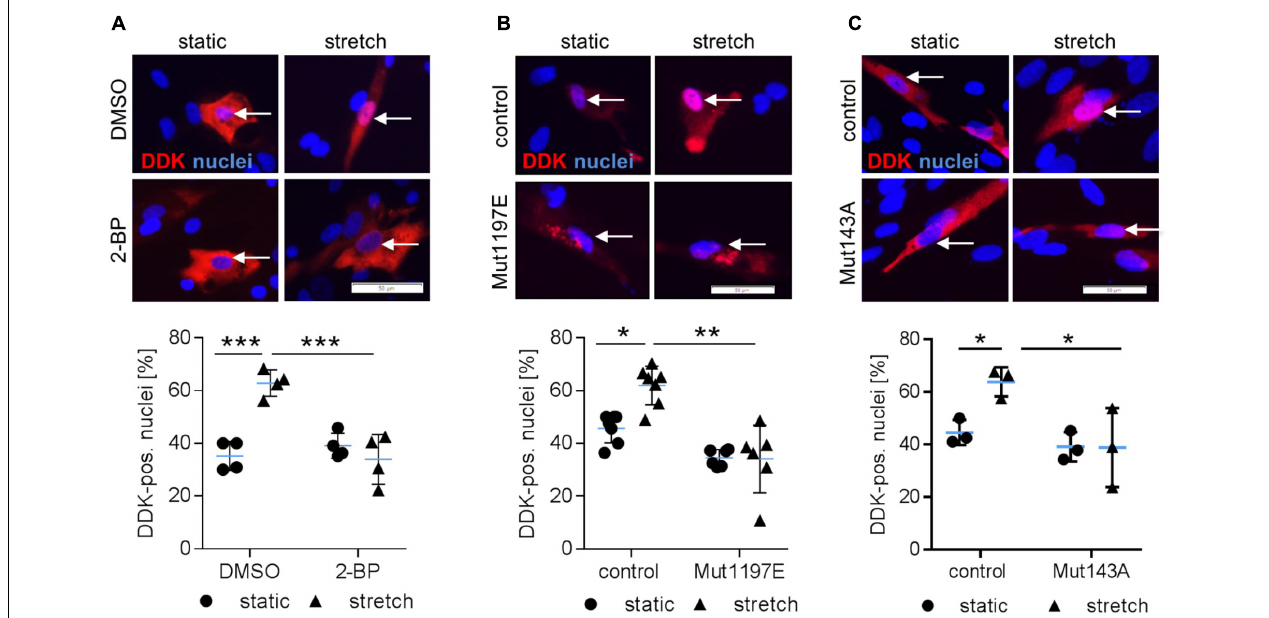
FIGURE 4 | Posttranslational modifications are required for NFAT5c to enter the nucleus of mechanoactivated VSMCs. NFAT5c was overexpressed in HUASMCs and the cells were exposed to biomechanical stretch (24 h). HUASMCs were treated with 2-bromopalmitate (inhibitor of protein palmitoylation, (A) , ∗∗∗ p < 0.001, n = 4, one-way ANOVA and Tukey post-test, scale bar: 50 µ m). Site directed mutagenesis of NFAT5c at serine 1197 (serine → glutamic acid) was performed to mimic phosphorylation at this site ( B , ∗ p < 0.05, ∗∗ p < 0.01, n = 6–7, one-way ANOVA and Tukey post-test, scale bar: 50 µ m). Site directed mutagenesis of NFAT5c at tyrosine 143 (tyrosine → alanine) was performed to prevent phosphorylation at this site ( C , ∗ p < 0.05, n = 3, one-way ANOVA and Tukey post-test, scale bars: 50 µ m). In all approaches (a-c), localization of NFAT5c in the nuclei was determined by immunofluorescence-based detection of DDK (automated image analysis) in stretch-stimulated